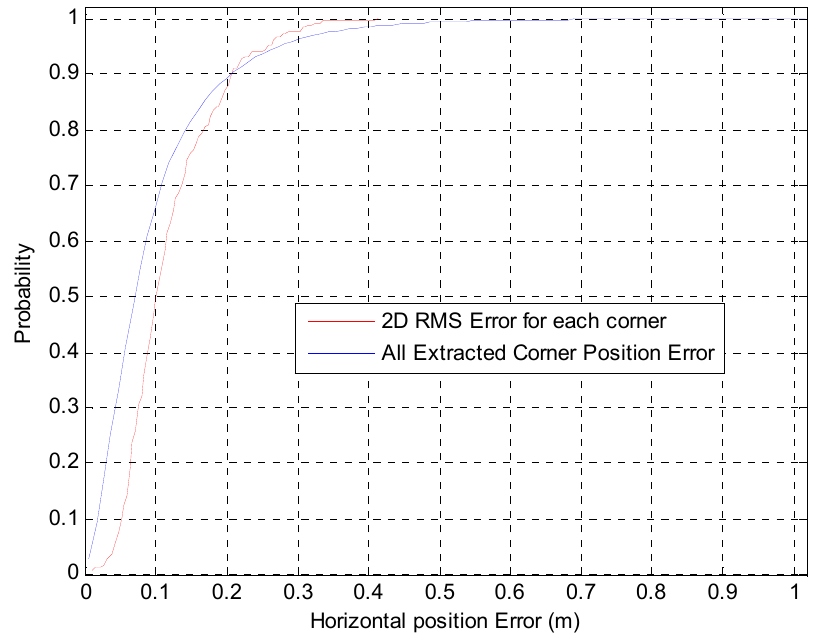
Figure 20. CDF of the 2D RMS horizontal errors for each corner and the horizontal position errors of all extracted corners.